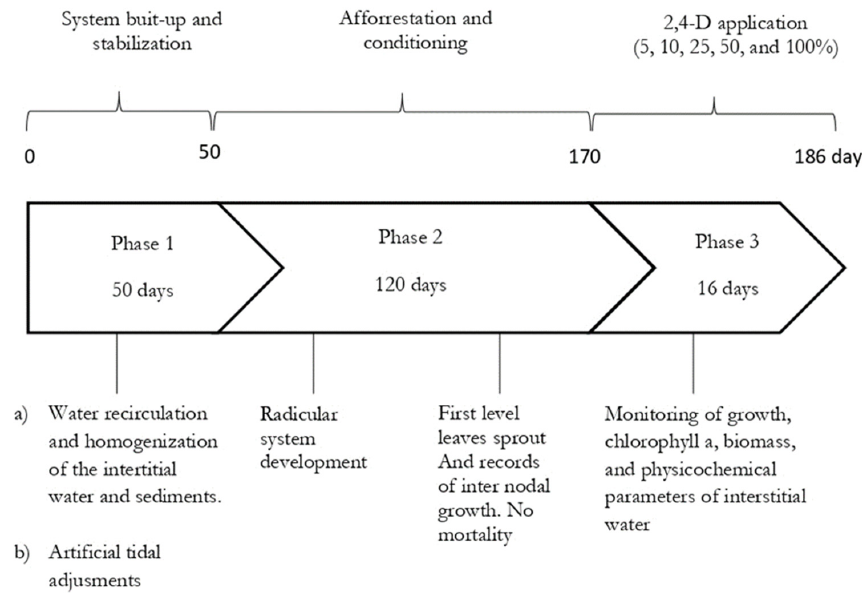
Figure 3. Experiment timeline events.